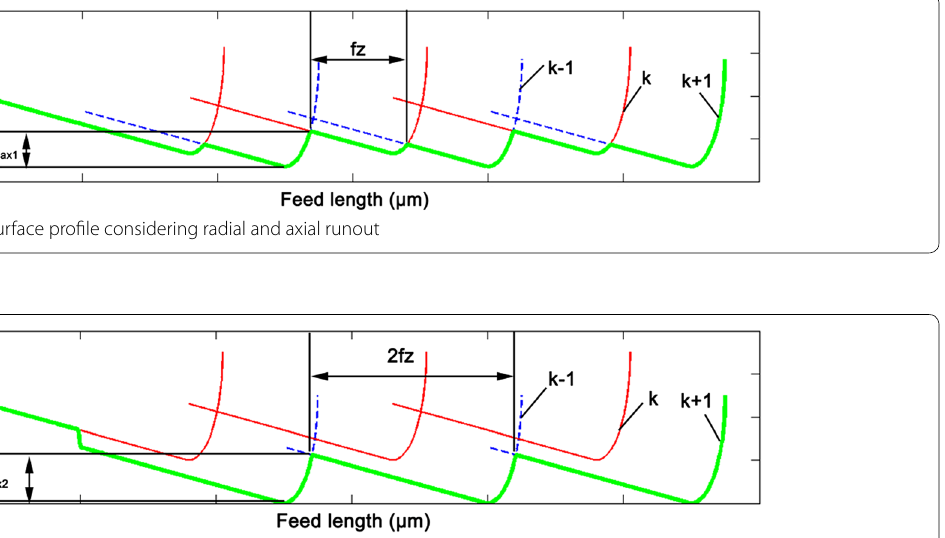
Figure 8 Third case of the surface profile considering radial and axial